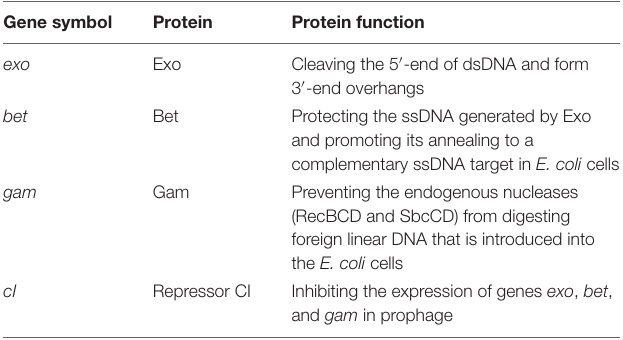
TABLE 6 | Genes involved in the Red homologous recombination system in lambda prophages. Gene symbol Protein Protein